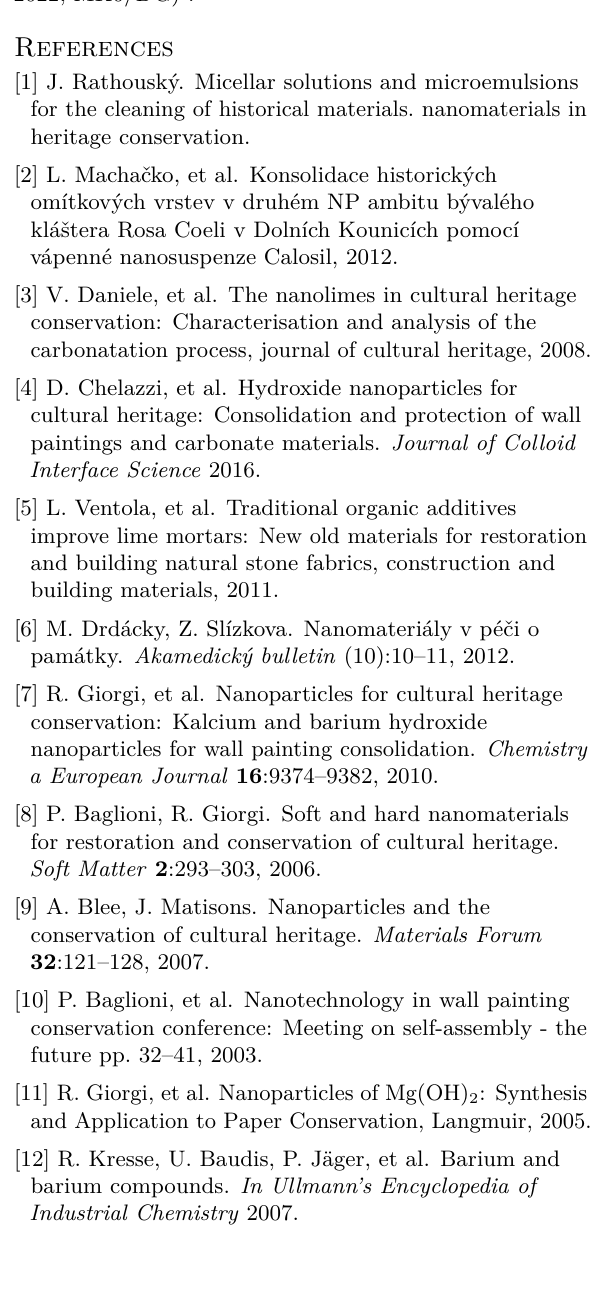
sample; 2 sample. 2